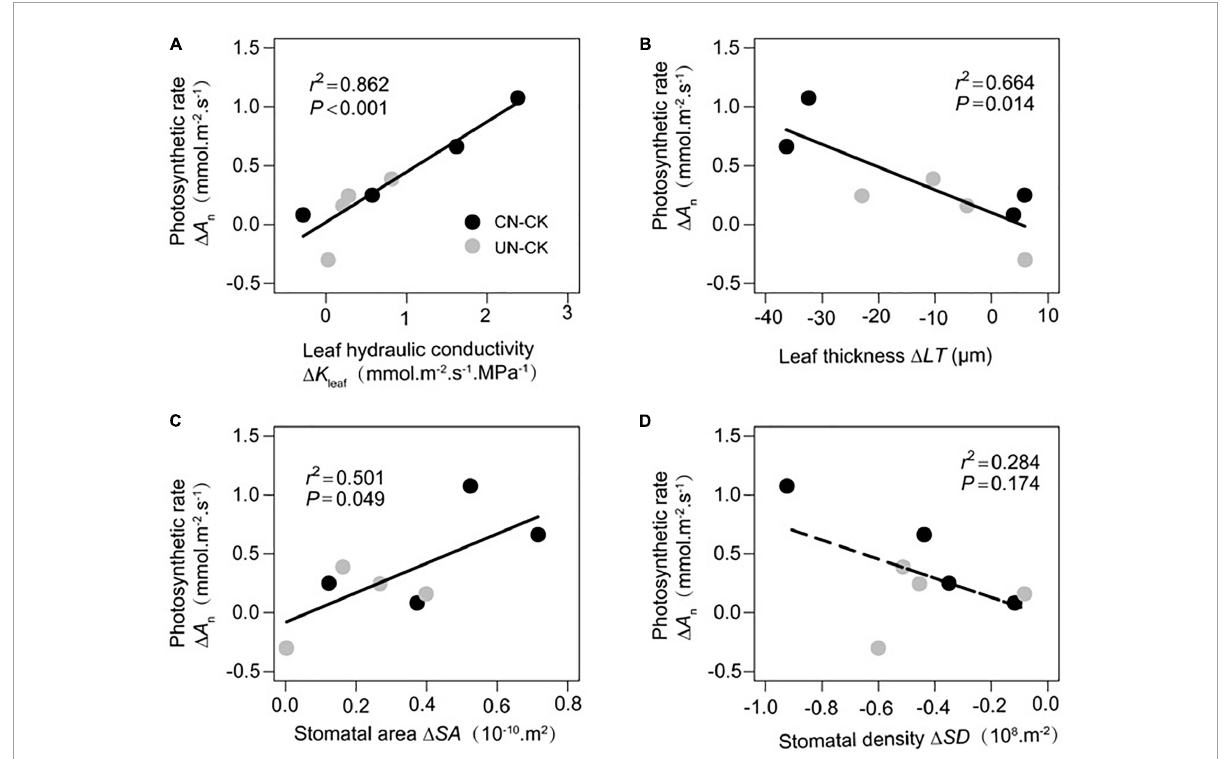
FIGURE4 Relationship between increments in photosynthetic rate ( (cid:49) A n ) and increments in leaf hydraulic conductivity ( (cid:49) K leaf , A ), leaf thickness ( (cid:49) LT , B ), stomatal area ( (cid:49) S A , C ), and stomatal density ( (cid:49) SD , D ). Gray and black circles represent CN minus CK and UN minus CK,